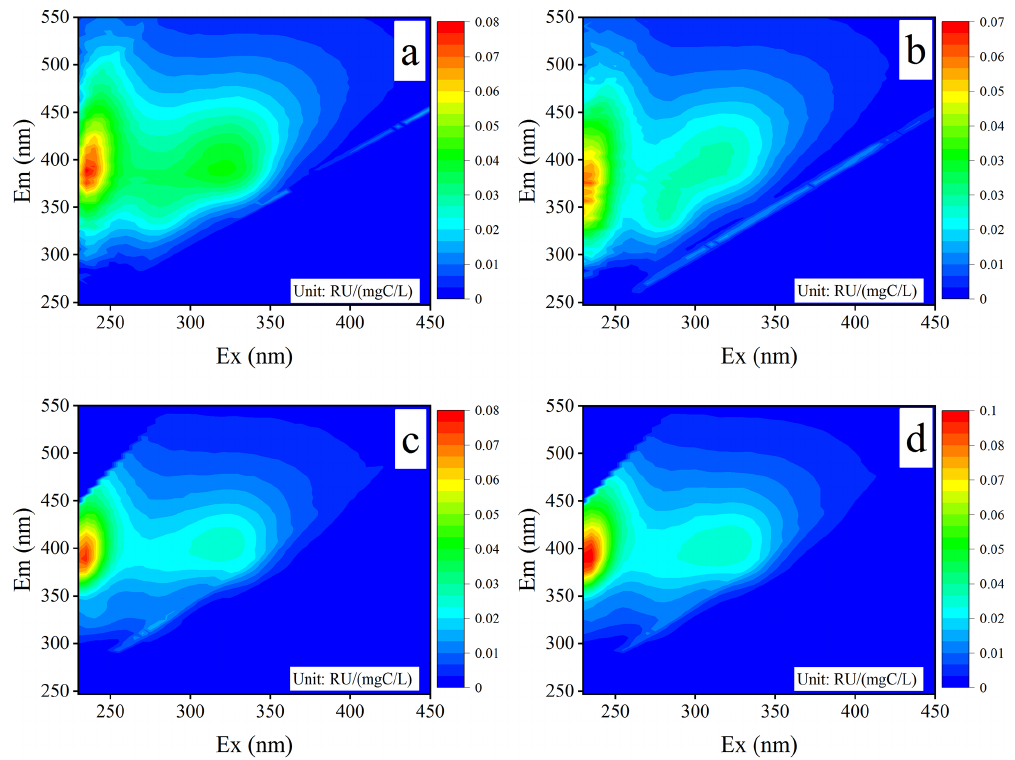
Figure 2. The three-dimensional EEM spectra of WSOM in atmospheric PM 2 . 5 samples for (a) Chuzhou (CZ), (b) Guangzhou (GZ), (c) GZ in the wet season, and (d) GZ in the dry season.